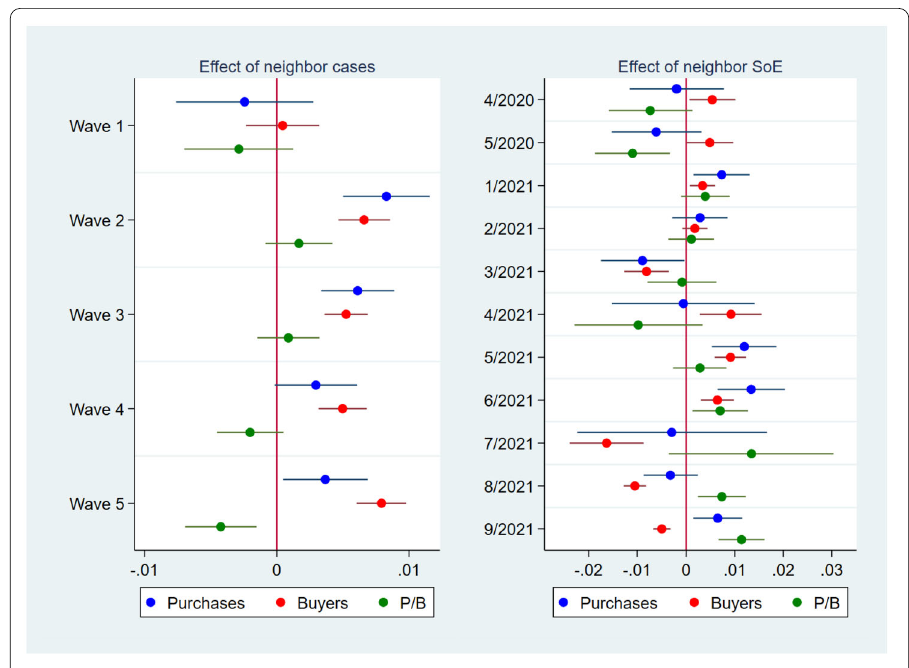
Figure 8 Effects of the Declaration of a State of Emergency in Neighboring Prefectures on the Purchase Amount, the Number of Buyers, and the Purchase Amount per Buyer. This figure illustrates the point estimates and 95% confidence intervals of the effect of the number of prefectures that were in a state of emergency (SoE) and shared any border with the focal prefecture in different months on the purchase amount (blue), the number of unique buyers (red), and the purchase amount per unique buyer (green) in logs. In all the regressions, the other independent variables are the dummies for an SoE; the dummies for before an SoE; the number of COVID-19 cases per 1000 persons; the number of neighboring prefectures in an SoE; and the prefecture, product, date, and day-of-the-week fixed effects. The standard errors are clustered at the city level. N =